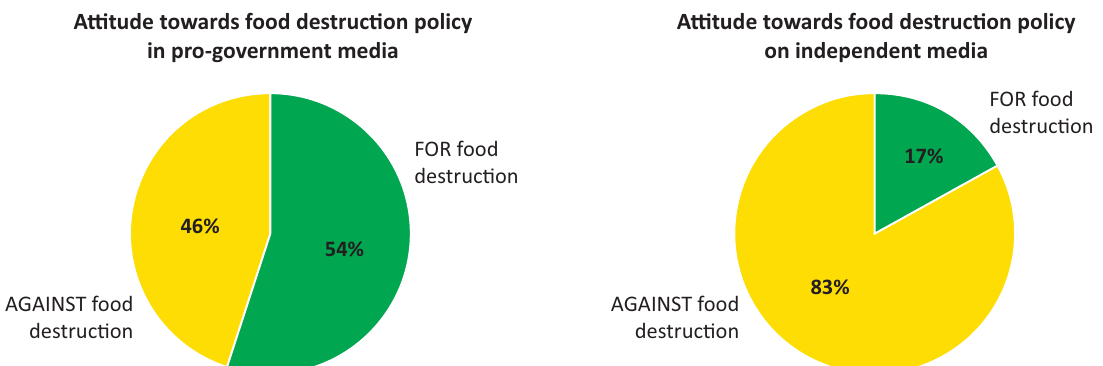
Figure 6. Intersubjective solidarities ‘For’ and ‘Against’ food destruction on pro-government and independent